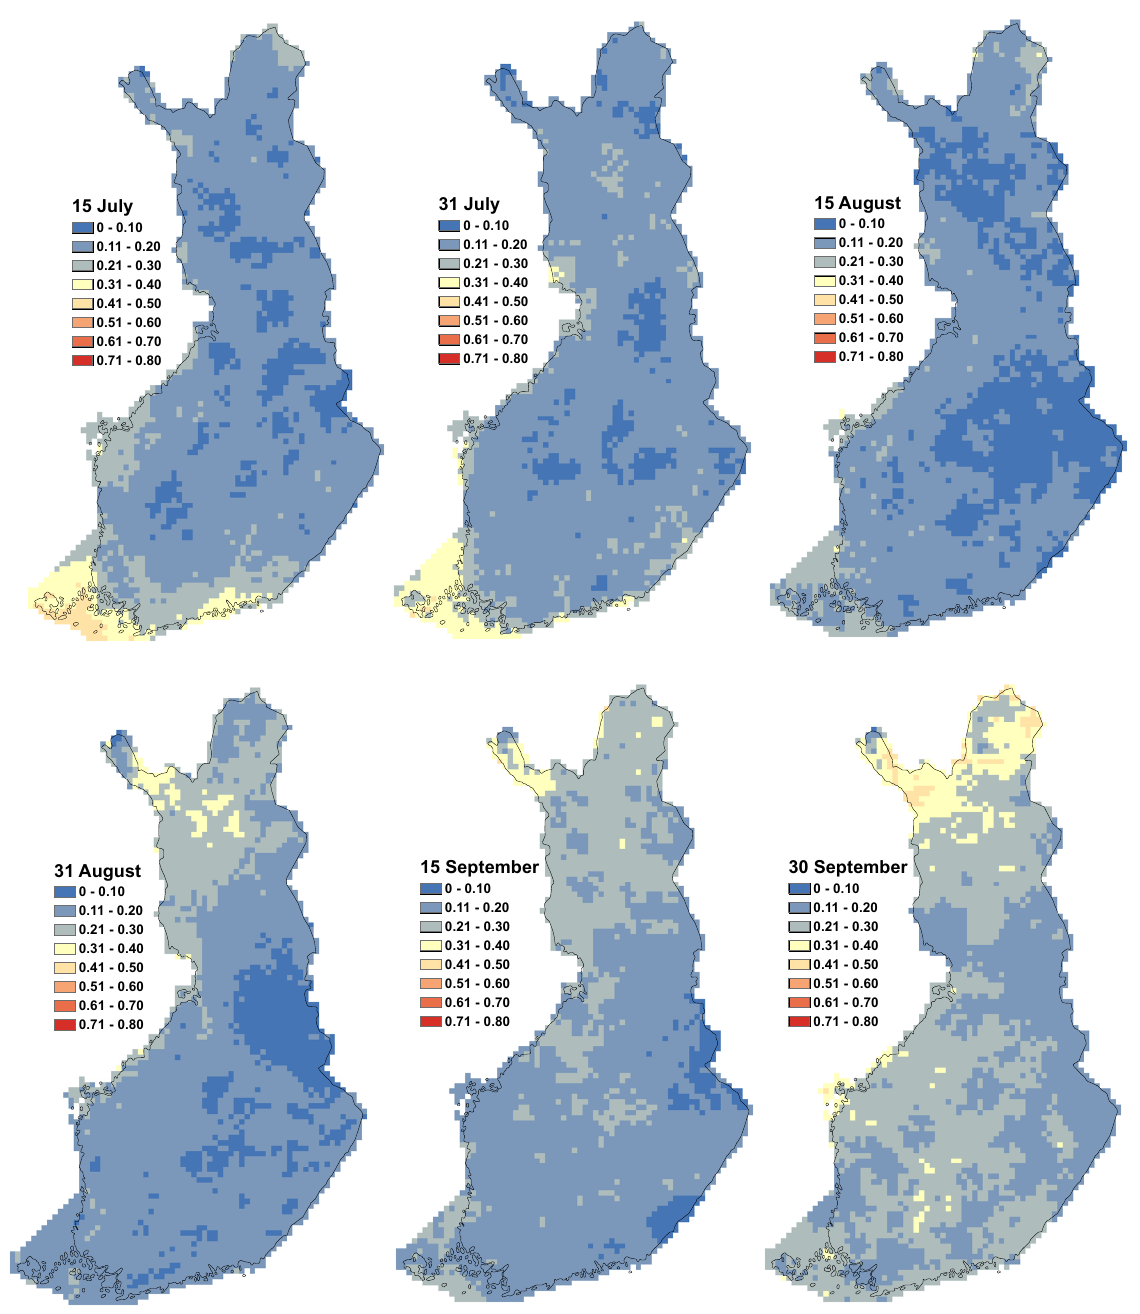
Fig. 1b. Probabilities of drought lasting for at least two weeks for the periods that ended on 15 July to 30